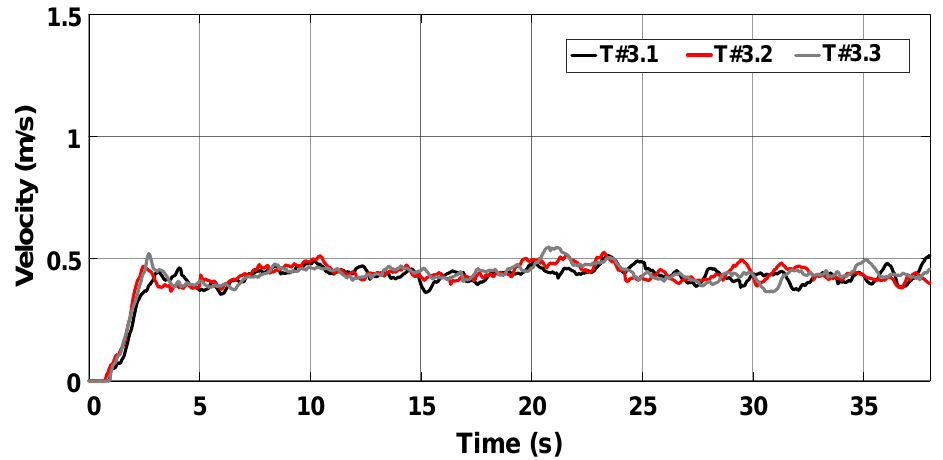
Figure 27. Control charts representing data obtained during the trial sessions carried out on firm soil with the slip automatically adjusted by the proposed control scheme.